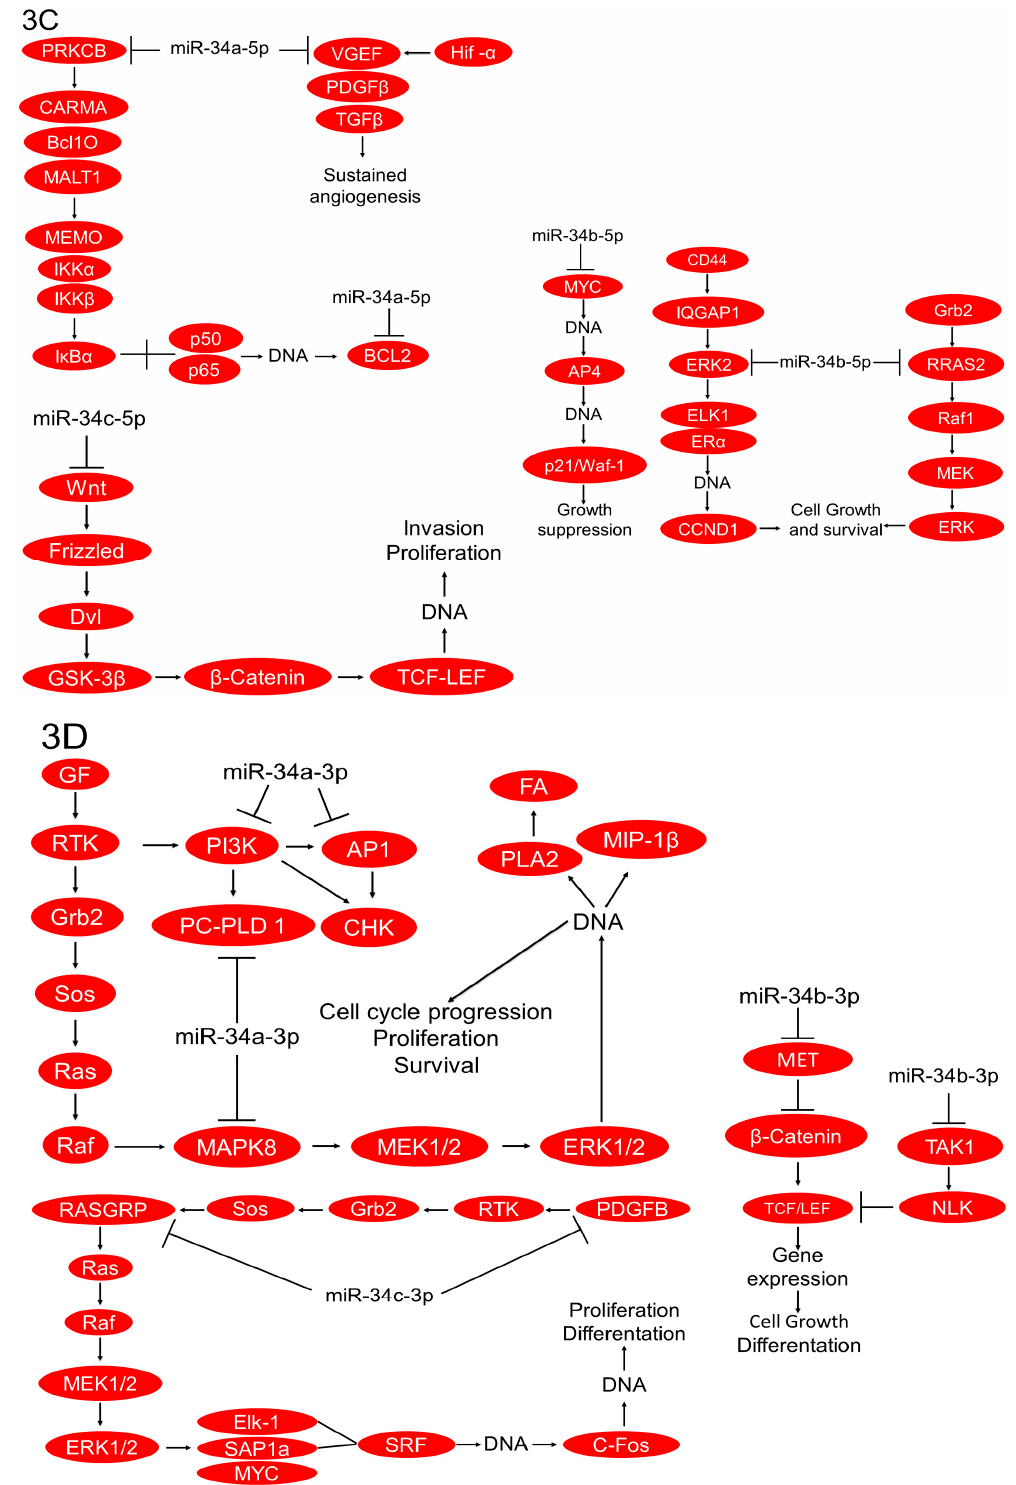
Figure 3. Potential targets of miR-34 family members searched on miRDB, DIANA-microT, and RNA22-HSA. ( A ) Messenger RNA (mRNA) targets of 5p strand of miR-34 family members were analyzed from data obtained in miRDB, DIANA-microT, and RNA22-HSA, and genes were grouped as common or individually regulated. ( B ) Targets of the 3p strand of miR-34 members were analyzed in miRDB, DIANA-microT, and RNA22-HSA, and genes were grouped as common or individually regulated. ( C